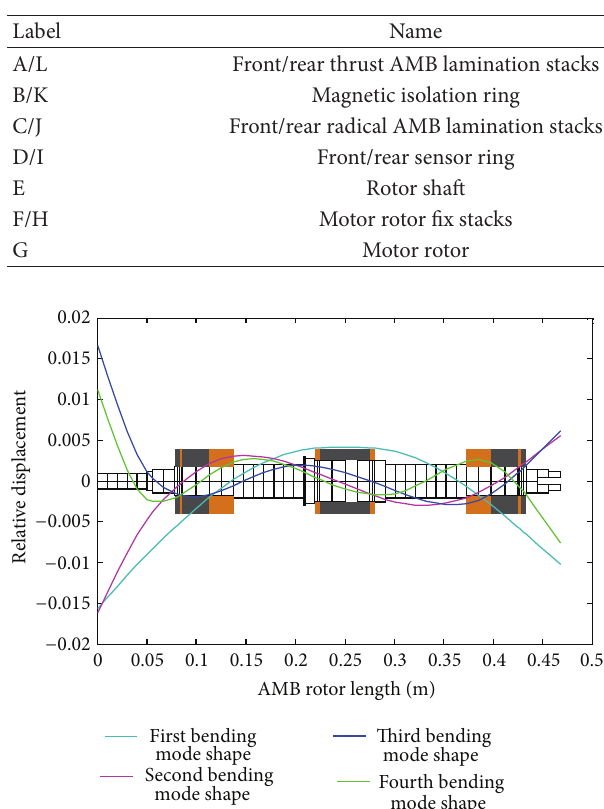
Table 1: Specific details of the rotor.